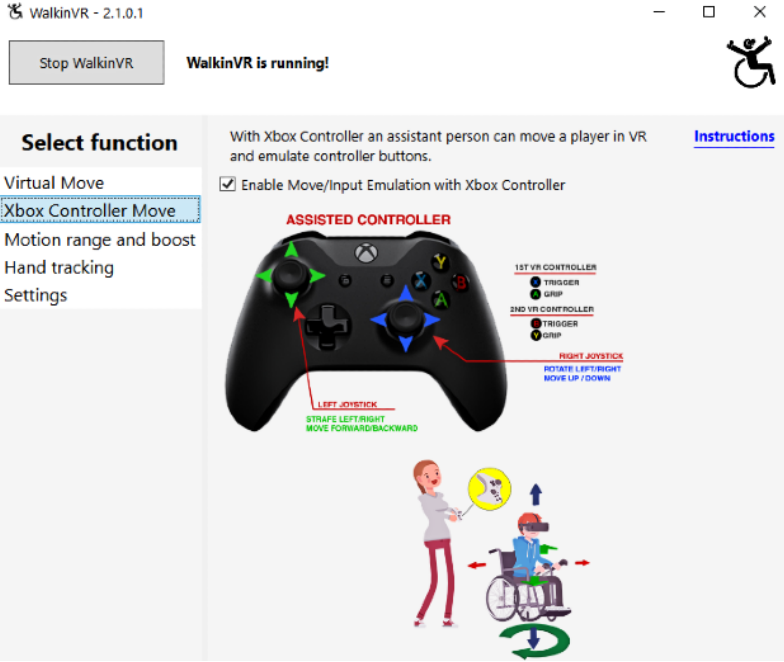
Figure 2. Screenshot of the WalkinVR controller